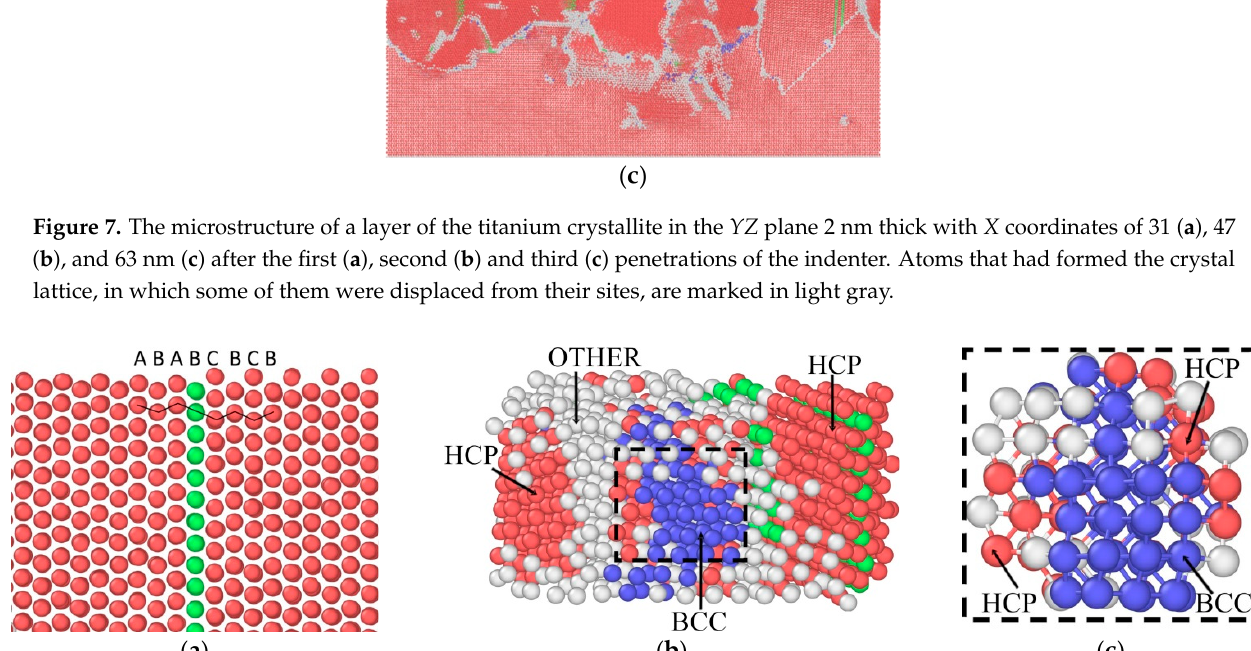
Figure 8. The formation of a stacking fault ( a ) and a local region with the bcc crystal lattice ( b ) in the titanium crystallite after three penetrations of the indenter. The color of atoms corresponds to different local configurations of the atomic lattice: blue is bcc, green is fcc, red is hcp, gray is an unidentified microstructure. Figure ( c ) corresponds to the central region fragment in ( b ) marked by a dotted line, depicting bonds between nearest atoms.